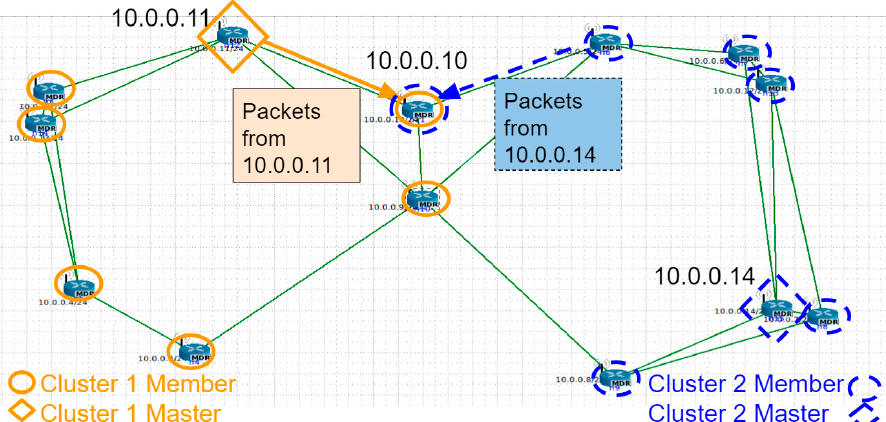
Figure 16. Multiple masters claim the same member.